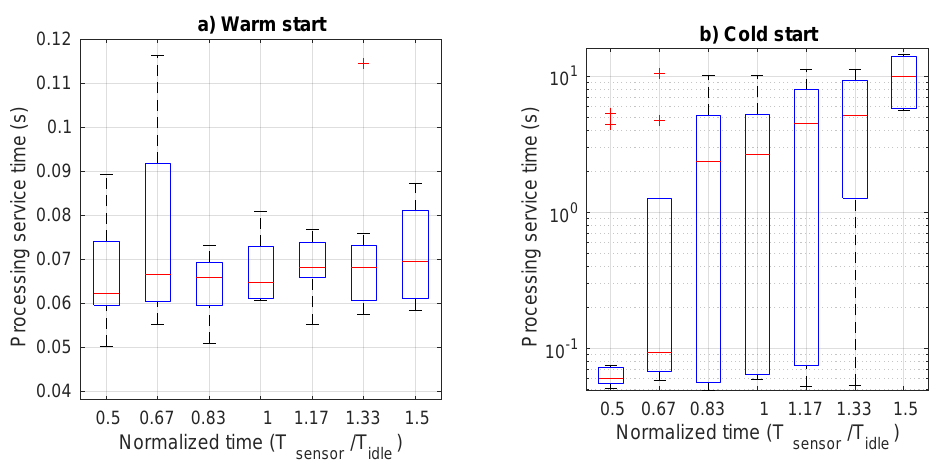
Figure 9. Boxplot of processing service time as a function of the normalized transmission period: ( a ) warm start and ( b ) cold